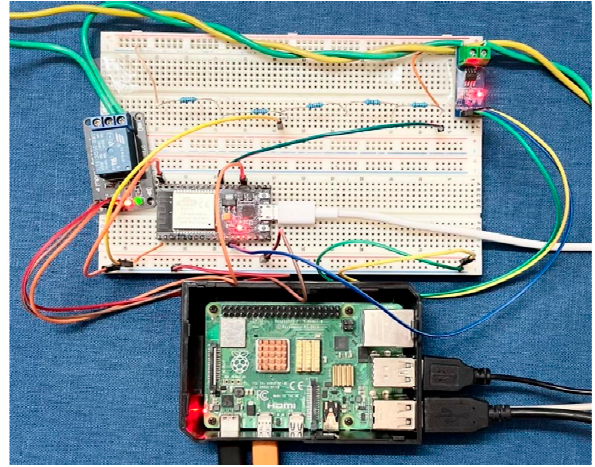
Figure 8. Hardware implementation of the low ‐ cost server.